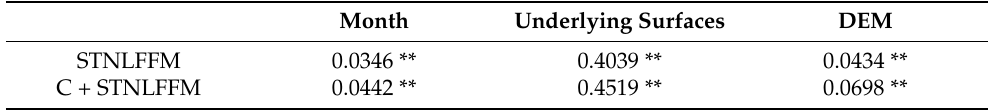
Table 4. PD values of month, underlying surfaces, and DEM for surface albedo based on STNLFFM and C +